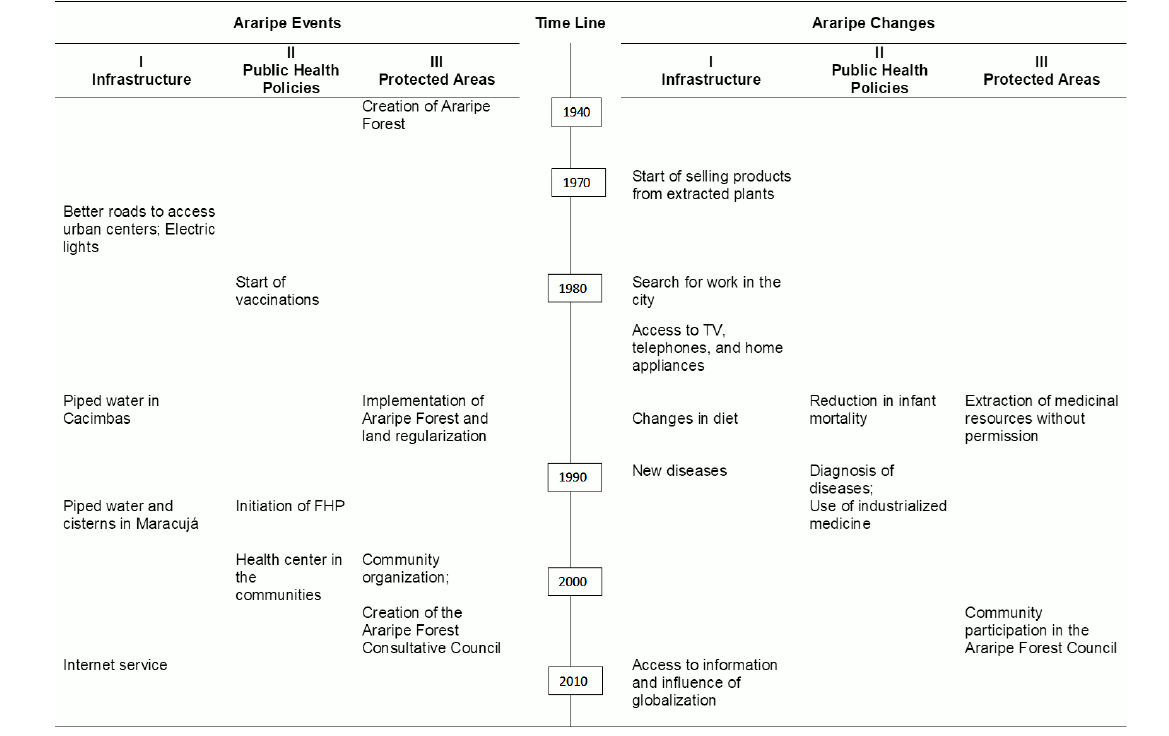
Fig. 3 . Events affecting traditional healthcare systems (THS) and resulting changes in rural communities of Chapada do Araripe, northeastern Brazil. FHP = Family Health